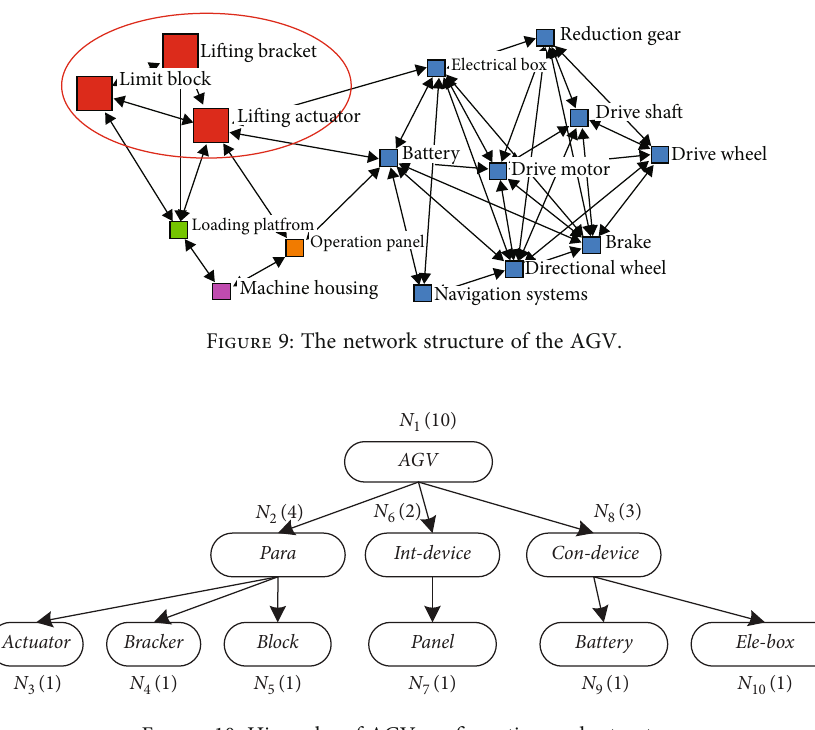
Figure 10: Hierarchy of AGV con fi guration node